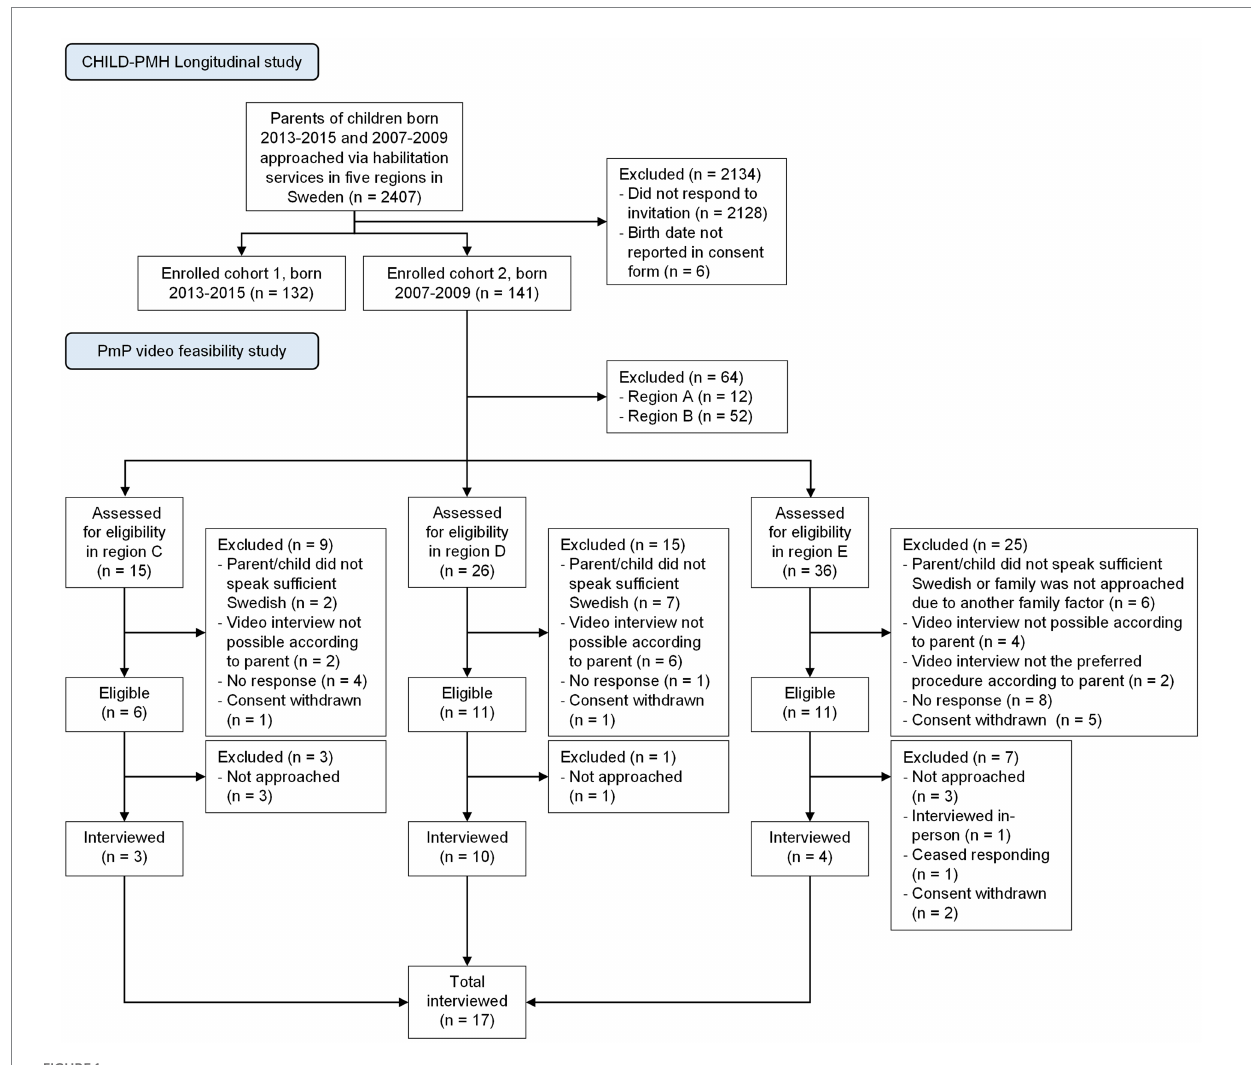
FIGURE 1 Recruitment strategy and flow of participants through the